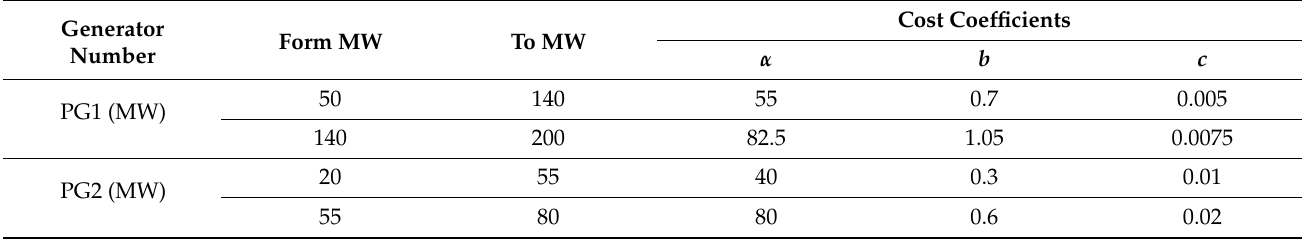
Table A2. Generator cost coefficients for Case 2.